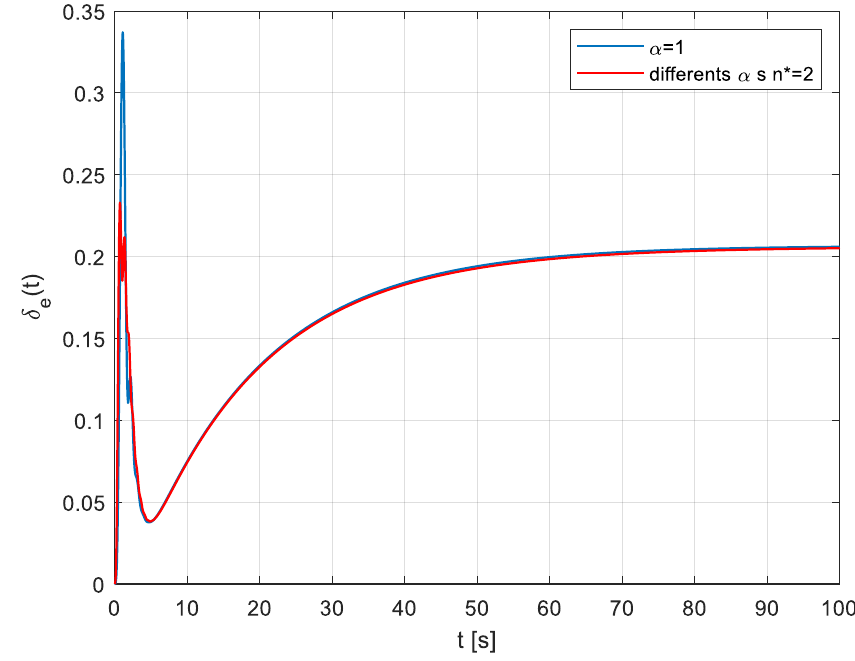
Figure 13. Control effort 𝛿 𝑒 (𝑡) with FO-DMRAC and IO-DMRAC.